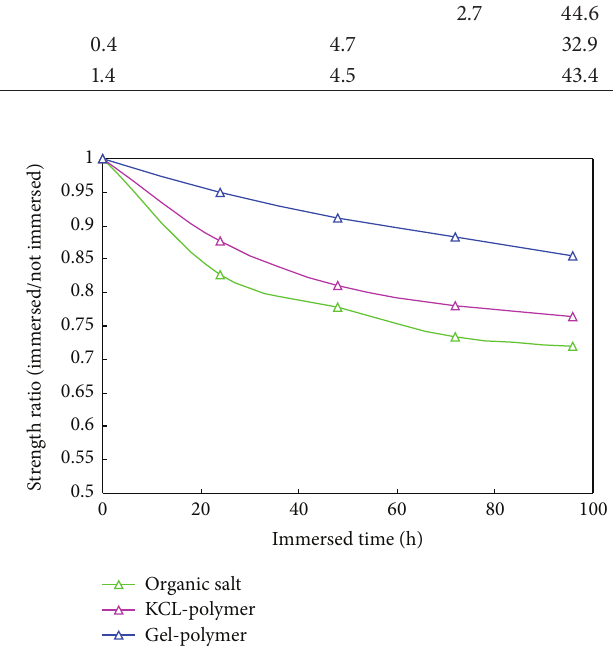
Figure 4: Comparison of the shale strength decrease after immers-